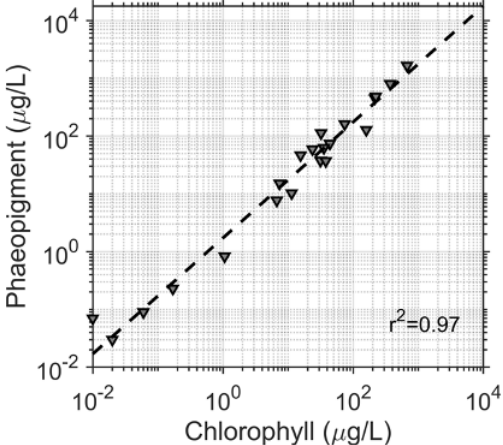
Figure 2. Correlation between chlorophyll and phaeopigments for all samples ( R 2 = 0 . 97) with a slope of 2.34. Concentrations were added together for the subsequent